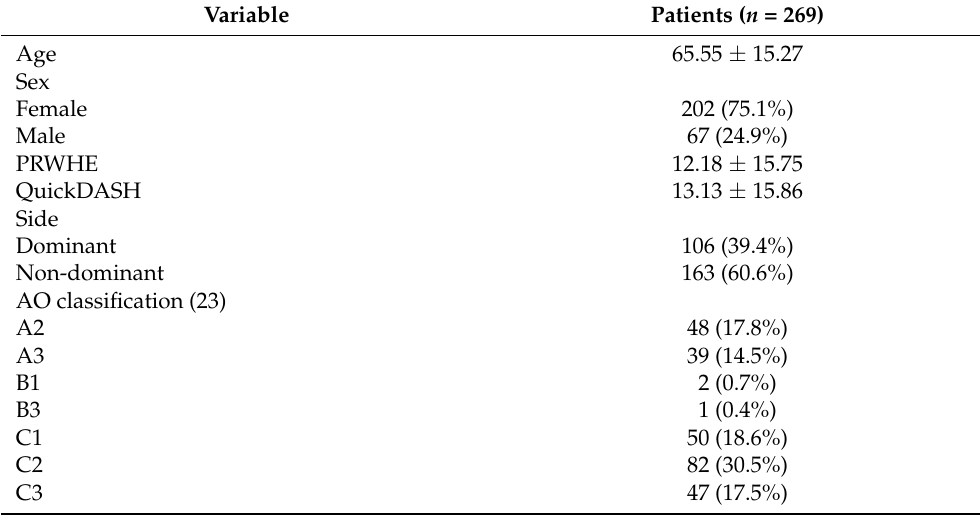
Table 1. Overall cohort characteristics.